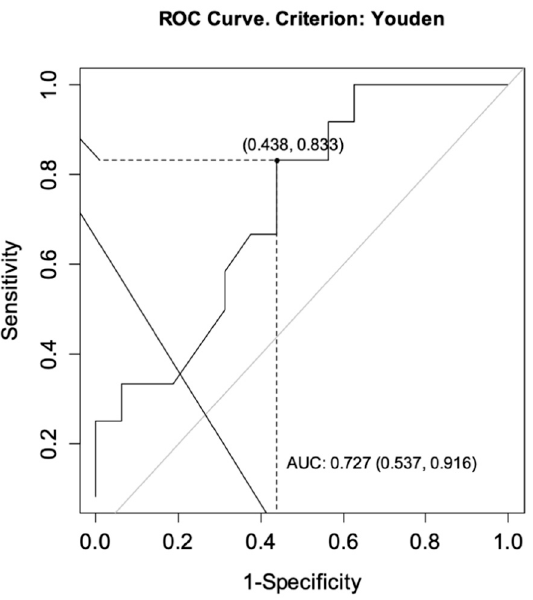
Figure 2. ROC curve for infliximab levels as a predictor of achieving a primary response while ensuring no secondary loss of response in patients with Crohn’s disease. AUC, area under the curve.